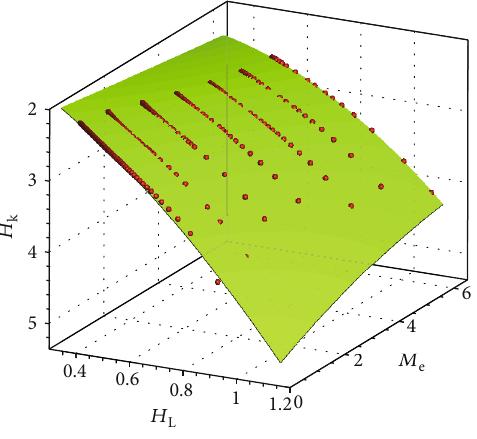
Figure 1: Relations among M